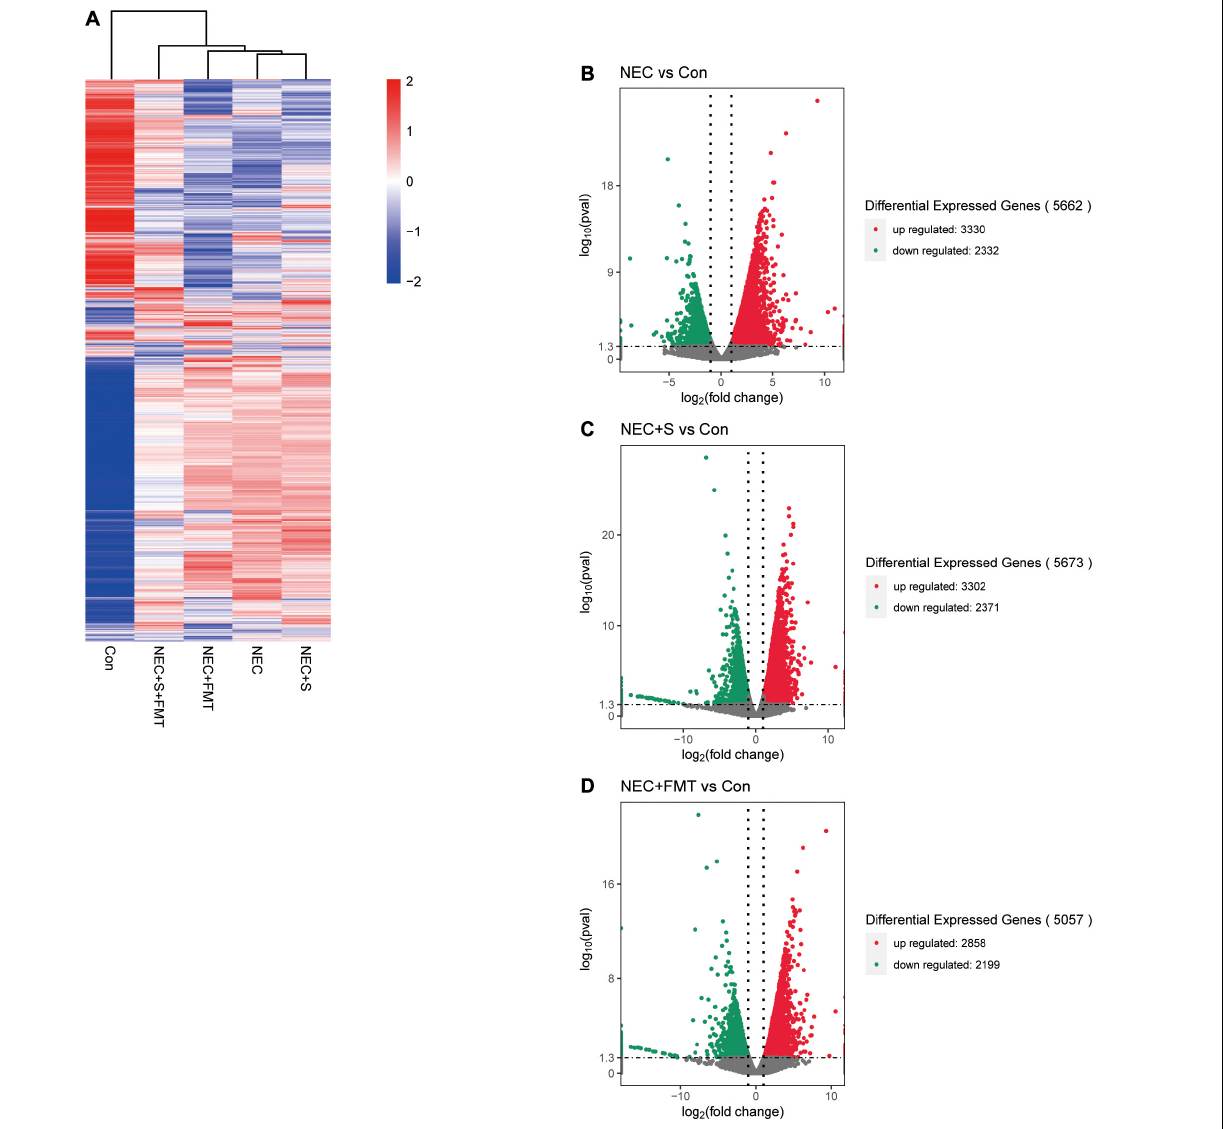
FIGURE 3 | The transcription profiles in five groups. (A) Transcription profiles of the different groups. (B) Volcano plot differential expression genes between NEC and Con. (C) Volcano plot differential expression genes between NEC plus sulperazone and Con. (D) Volcano plot differential expression genes between NEC plus FMT and Con. Con, control; NEC, necrotizing enterocolitis; S, Sulperazone; FMT, fecal microbiota transplantation.